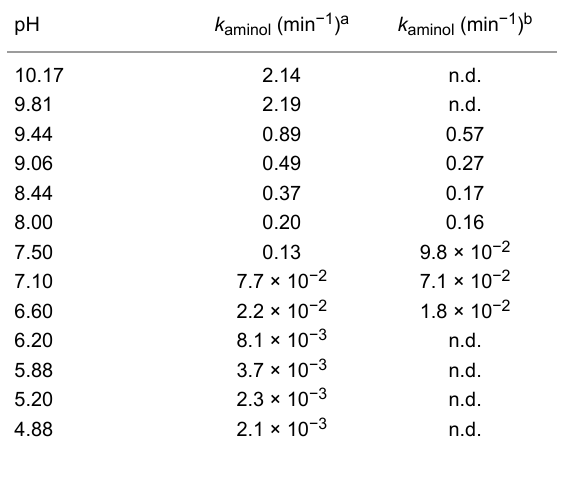
Table 2: Observed kinetic data for the aqueous aminolysis and hy- drolysis of p -nitrophenyl ester 7 (R = p NP) a and m -nitrophenyl ester 7 (R = m NP) b in the presence of 0.05 M D-glucosamine at 25 °C (n.d. = not